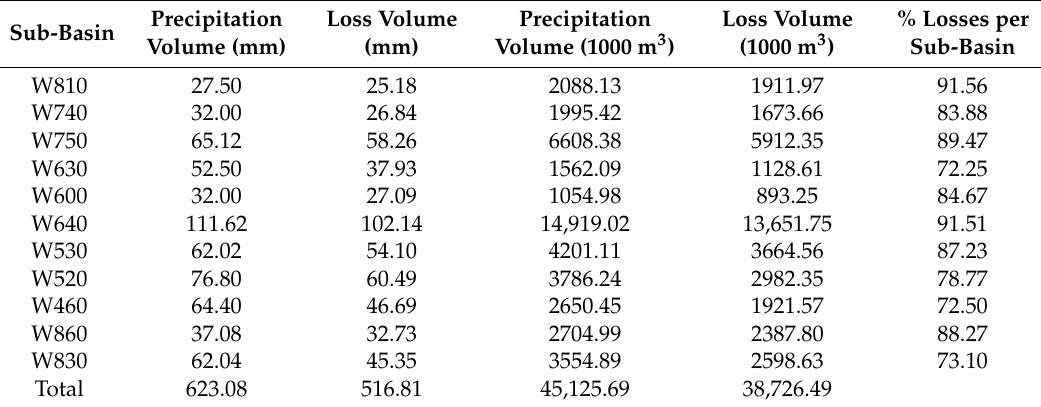
Table 13. Basin losses of 1991.